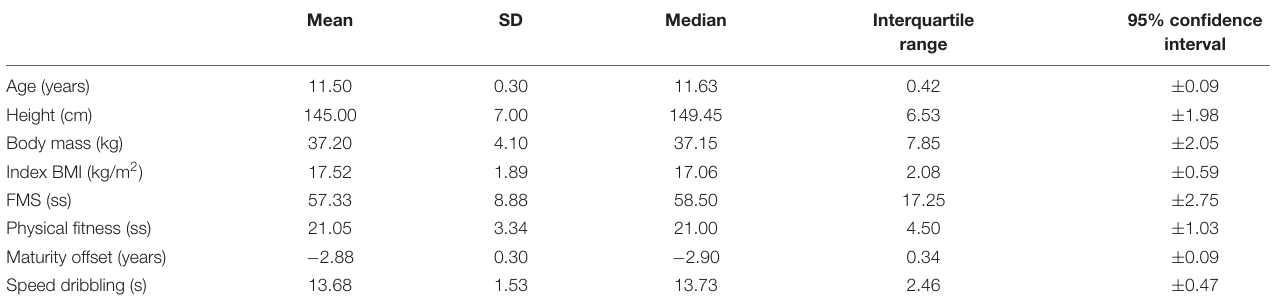
TABLE 2 | Basic descriptive statistics ( n = 40).